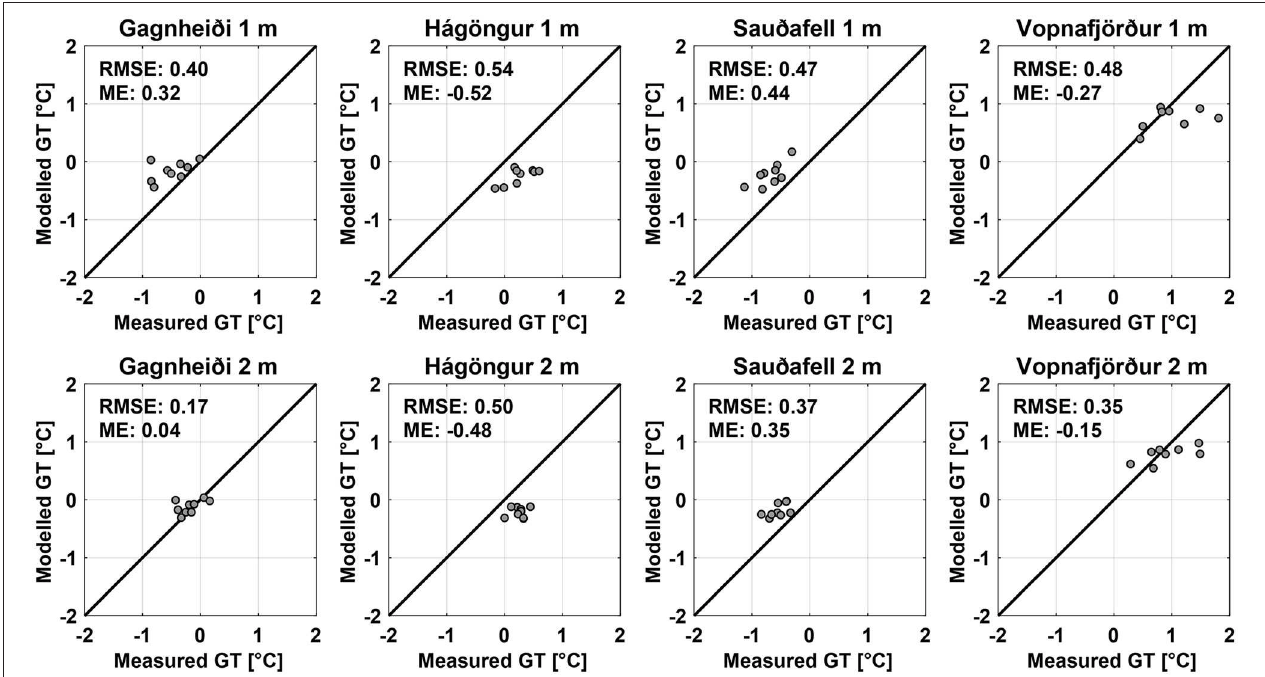
FIGURE 5 | Yearly validation of the modelled ground temperature (GT) at 1 and 2m depth for the borehole locations. In these simulations, precipitation fraction of 50% was used. RMSE-root mean square error, ME-mean